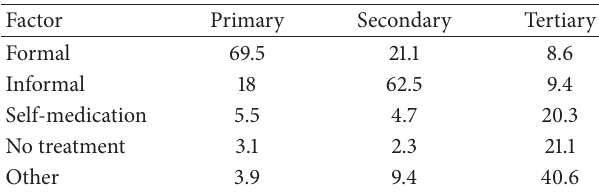
Table 2: Top picks for outpatient services.